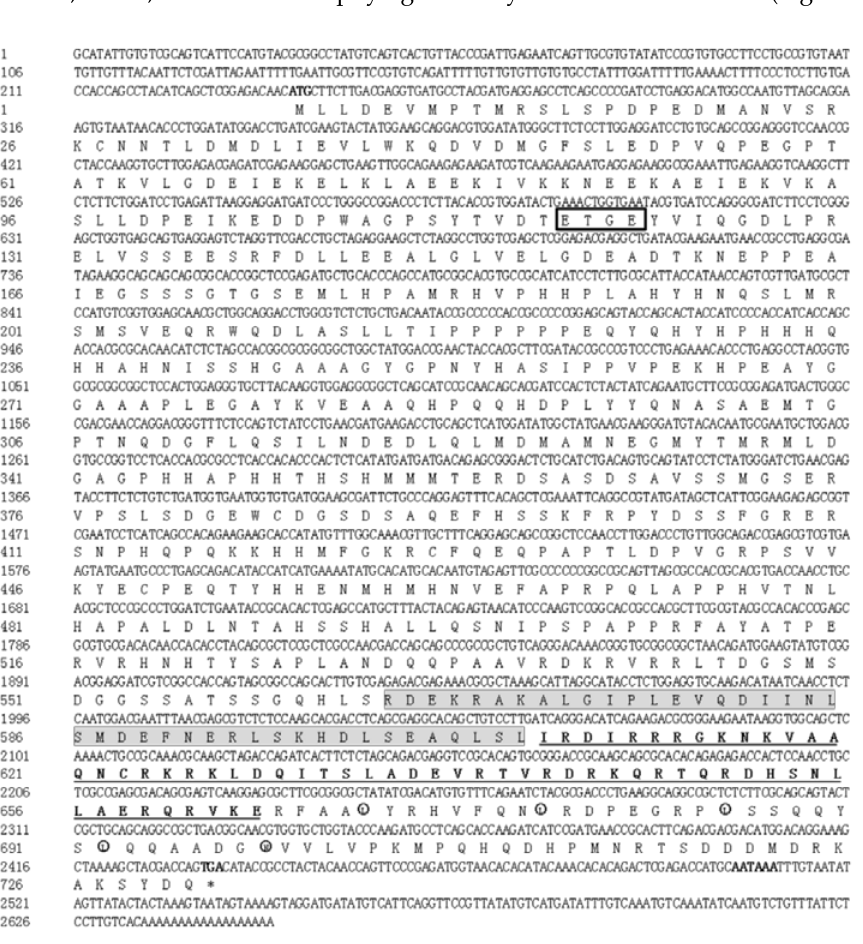
Figure 1. Nucleotide and deduced amino acid sequence of Sf CncC. The start codon (ATG), stop codon (TAA), and putative polyadenylation signal (AATAAA) are bond highlighted. The tetrapeptide motif (ETGE) are boxed, amino acids participating in the putative leucine-zipper dimerization domain are circled, the CNC-bZIP DNA binding domain are shown bonded and underlined, and the Cnc homology region (conserved in the NF-E2 family) is shaded.